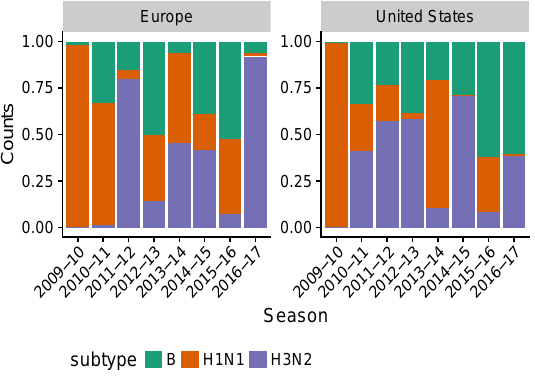
Figure A5. Seasonal subtype frequencies in the United States and Europe. European frequencies are calculated as an average of country-level frequencies, weighted by population size.